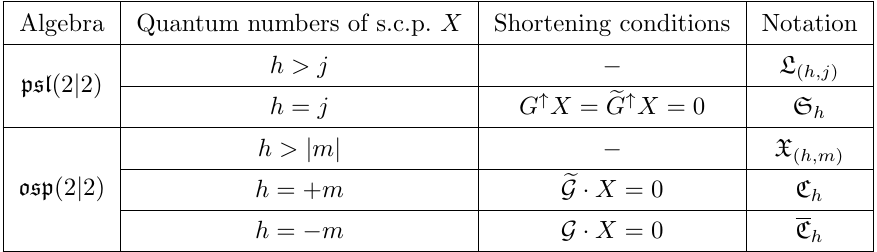
Table 2 . Representations of psl (2 j 2) and osp (2 j 2) that appear in this work. We use X to the denote the superconformal primary, or s.c.p. for short. The symbol G " X denotes the descendant of X with weight h + 1 and spin j + 1 obtained by acting once with the supercharge G . The notation 2 2 G (cid:1) X stands for the descendant of X with weight h + 1 and charge m + 1 obtained by acting once 2 2 with the supercharge G . Similar remarks apply to e G " X , e G (cid:1) X . More details on our notation can be found in appendix